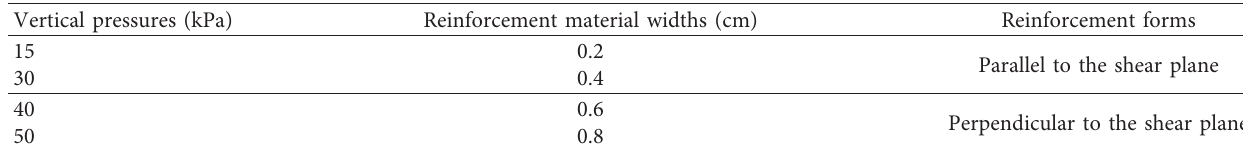
Figure 4: Diagram of directions and test methods of reinforcements in ring shear tests. Table 1: Test